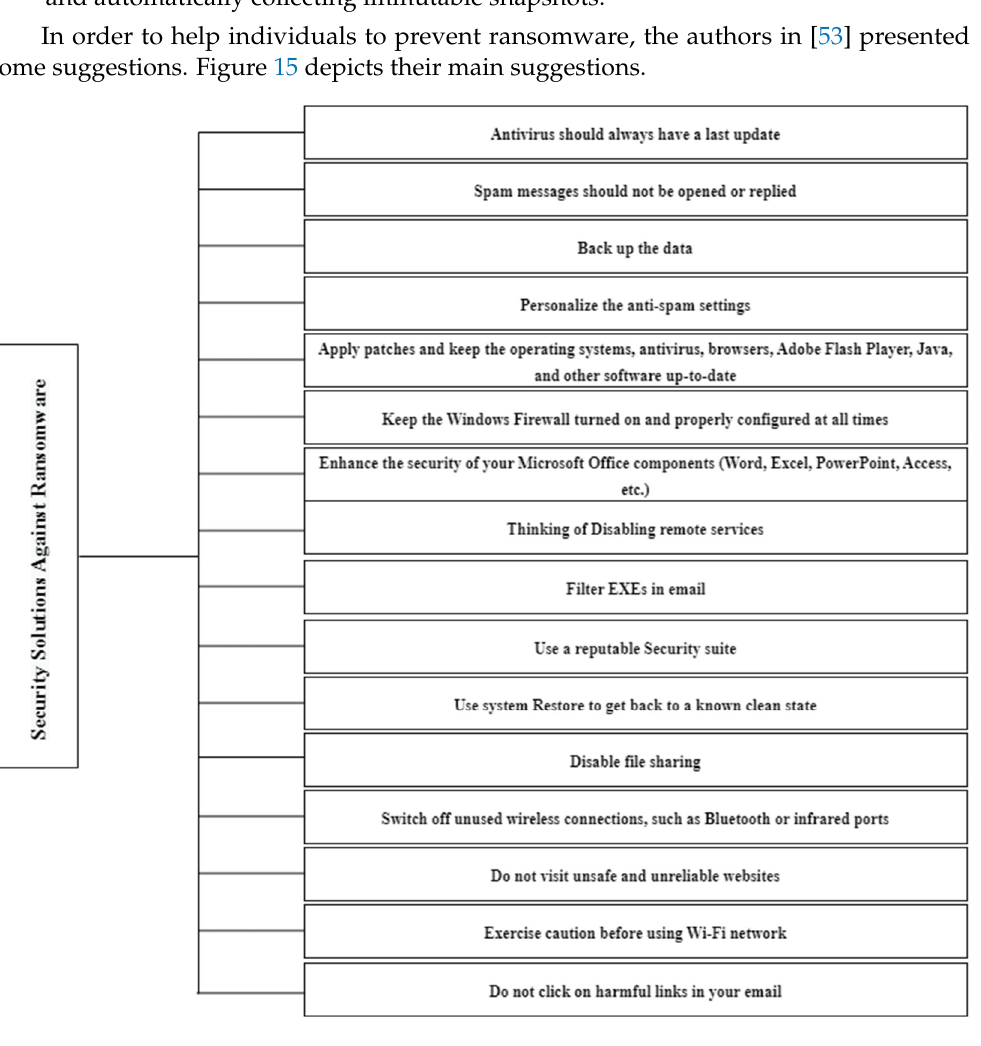
Figure 15. Security best practices to prevent ransomware. Adapted with permission from Ref. [54].